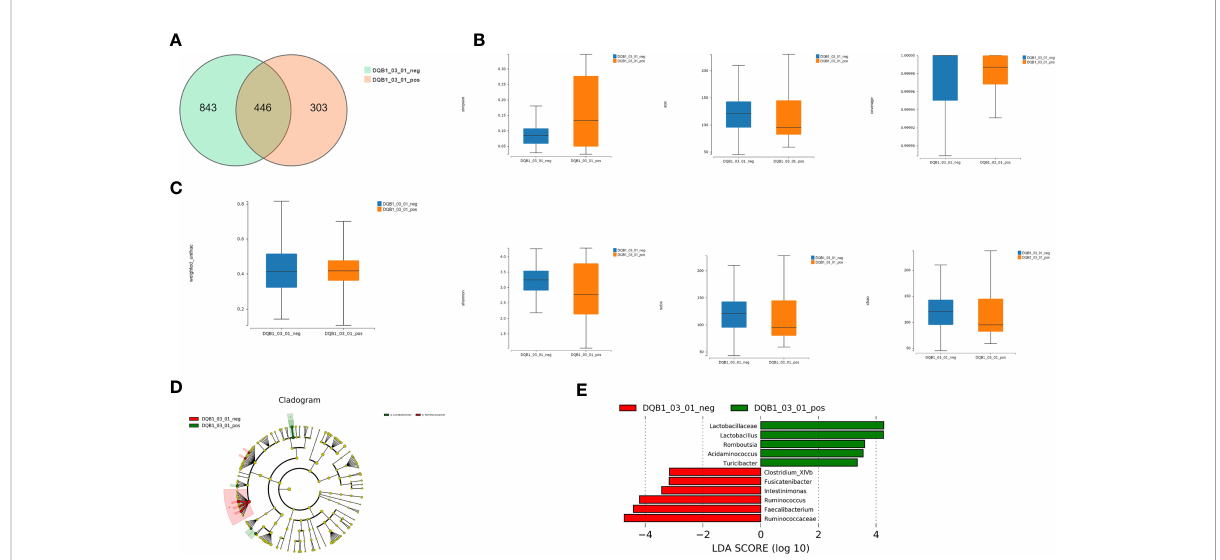
FIGURE 3 Richness and diversity analysis. (A) We detected 446 shared universal OTUs in samples from both DQB1*03:01 -positive and DQB1*03:01 -negative patients. DQB1*03:01 -negative patients contained more unique OTUs than did DQB1*03:01 -positive patients (843 vs. 303 OTUs). (B) a -diversity analysis revealed non-signi fi cant differences in the Simpson ’ s, Shannon ’ s, Sobs, ACE, Chao, and other observed species indexes between the two patient groups ( P >0.05). (C) Microbial communities did not statistically differ between these two groups ( P >0.05). (D) LEfSe analysis showed that the DQB1*03:01 -negative patient samples contained mainly Ruminococcaceae at the family level, and the DQB1*03:01 -positive samples contained mainly Lactobacillaceae. (E) Lactobacillaceae, Lactobacillus , Romboutsia , Acidaminococcus , Turicibacter , Clostridium_XlVb , Fusicatenibacter